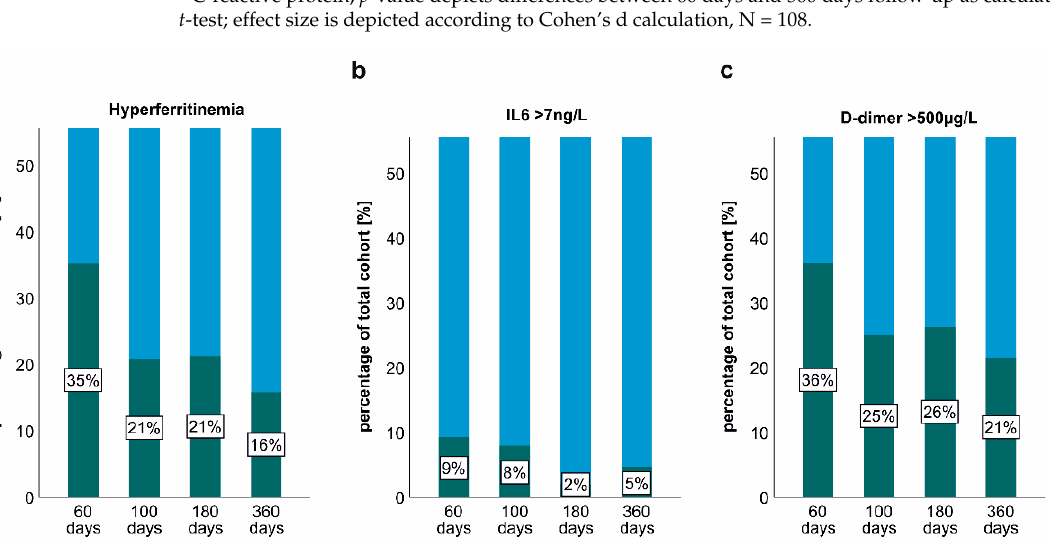
Figure 2. Persisting thrombo-inflammation at post-COVID-19 follow-up. ( a ) Prevalence of hyperfer- ritinaemia 60, 100, 180 and 360 days after COVID-19 onset. ( b ) Persisting elevations of IL6 60, 100, 180 and 360 days after COVID-19 onset. ( c ) Persisting elevations of d-dimer 60, 100, 180 and 360 days after COVID-19 onset. The green colour indicates the relative percentages of the total cohort with hyperferritinaemia, IL6 or D-dimer elevations, whereas the blue colour indicates the relative portion of patients without hyperferritinaemia, IL6 or D-dimer elevations.